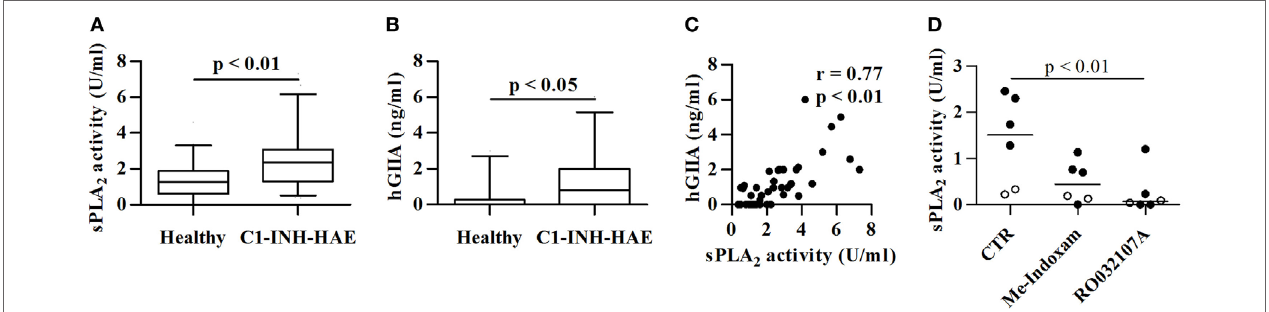
FigUre 1 | Plasma levels sPLA 2 activity and hGIIA protein in symptom-free with C1-INH-HAE patients and healthy controls. Data are shown as the median (horizontal black line), the 25th and 75th percentiles (boxes) and the 5th and 95th percentiles (whiskers) of 68 healthy controls and 109 C1-INH-HAE patients for sPLA 2 (a) and 36 controls and patients for hGIIA assessment (B) . Correlation between sPLA 2 and hGIIA (c) was assessed by Spearman’s correlation analysis and reported as coefficient of correlation ( r ). (D) Plasma of patients with C1-INH-HAE (black circles) and of healthy controls (white circles) was pre-incubated (20 min, 37°C) with Me-Indoxam (100 nM), RO032107A (100 nM), or control medium. At the end of incubation, sPLA 2 activity was